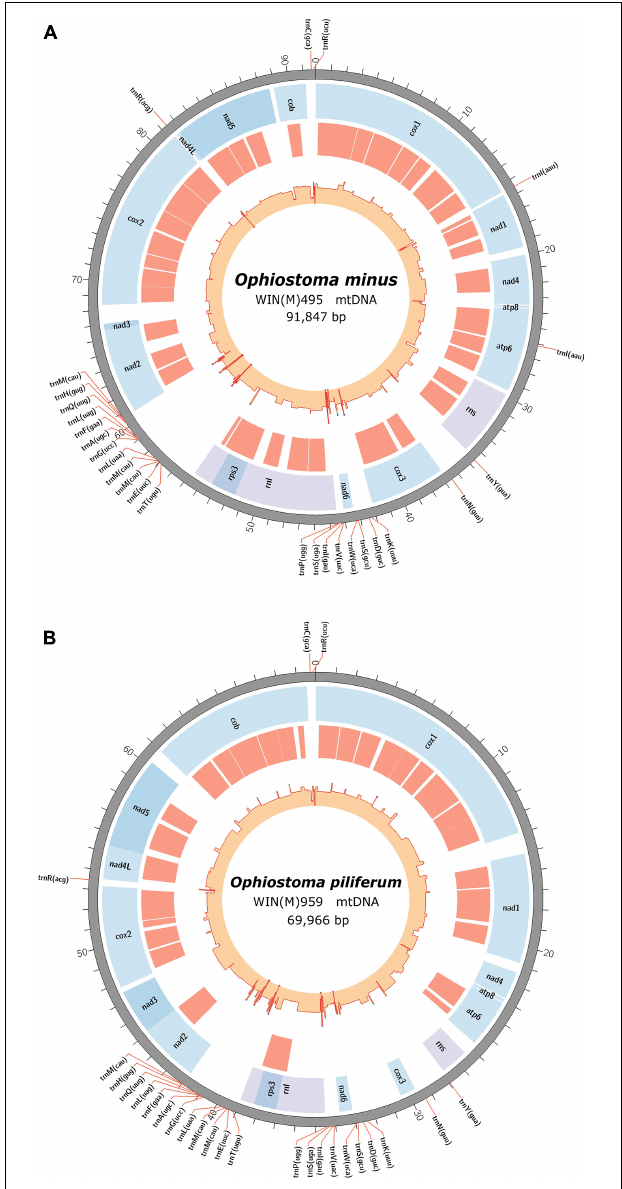
FIGURE 1 | Circular representation of the mitochondrial genomes showing the tRNA (pointed outward on the scale), protein coding genes (blue track), introns (red track), and genetic-feature-wise GC graph (GC% was calculated for annotated features instead of fixed window, showed in the innermost track). (A) The annotated mitochondrial genome of Ophiostoma minus ; total size of the circular genome is 91,847 bp (GenBank accession: MW122509.1). (B) The annotated mitochondrial genome of Ophiostoma piliferum ; total size of the circular genome is 69,966 bp (GenBank accession: